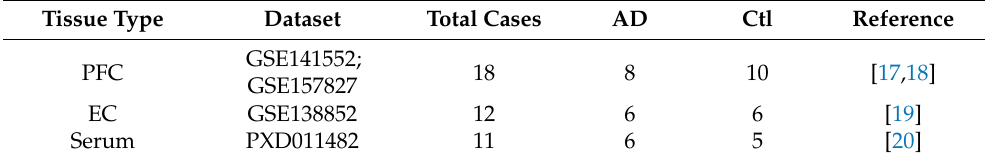
Table 1. Sample information. PFC: prefrontal cortex; EC: entorhinal cortex; Ctl: